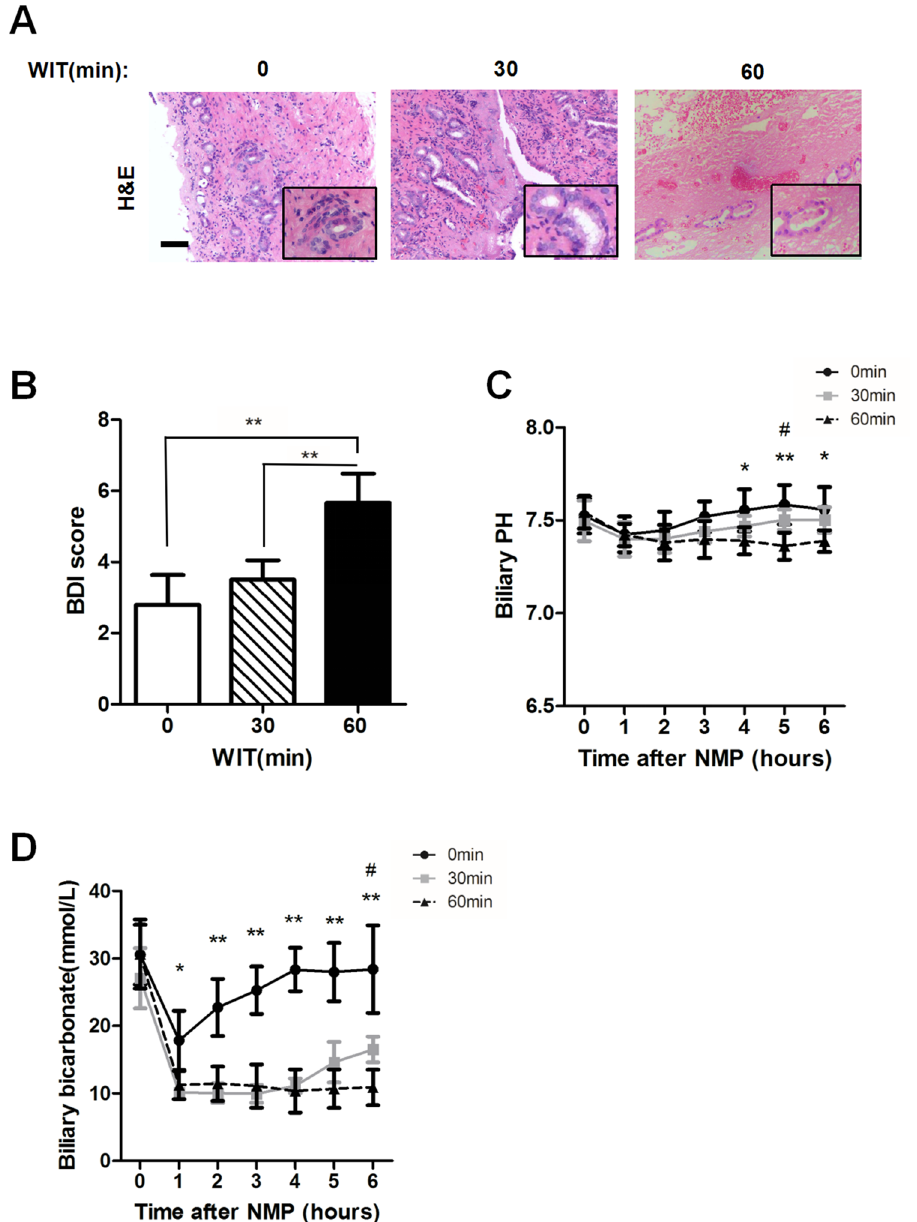
Figure 3. Detection of biliary duct injury (BDI) in different degree of warm ischemia injury. ( A ) Histological images of the bile duct with indicated WIT (0 ′ , 30 ′ , 60 ′ ). Scale bar = 100 μm. ( B ) Evaluation of BDI score of the bile duct with indicated WIT. (data represent mean ± SD. Student’ s t-test was used for analyzing between groups.* P < 0.05, ** P < 0.01). ( C ) The evaluation of biliary pH of livers with different WIT (0 ′ , 30 ′ , 60 ′ ). Bile samples were collected at indicated time points after NMP. Biliary pH was tested at different time points after NMP initiation (data represent mean ± SD. Two-way ANOVA was used for analyzing the differences among three groups. Group a (0 ′ ) vs. Group c(60 ′ ): * P < 0.05, ** P < 0.01;Group b (30 ′ ) vs. Group c (60 ′ ): # P < 0.05, ## P < 0.01). ( D ) The evaluation of biliary bicarbonate of livers with different WIT (0 ′ , 30 ′ , 60 ′ ). Bile samples were collected at indicated time points after NMP. Biliary bicarbonate was tested at different time points after NMP initiation (data represent mean ± SD. Two-way ANOVA was used for analyzing the differences among three groups. Group a (0 ′ ) vs. Group c (60 ′ ): * P < 0.05, ** P < 0.01; Group b (30 ′ ) vs. Group c (60 ′ ):# P < 0.05, ## P <